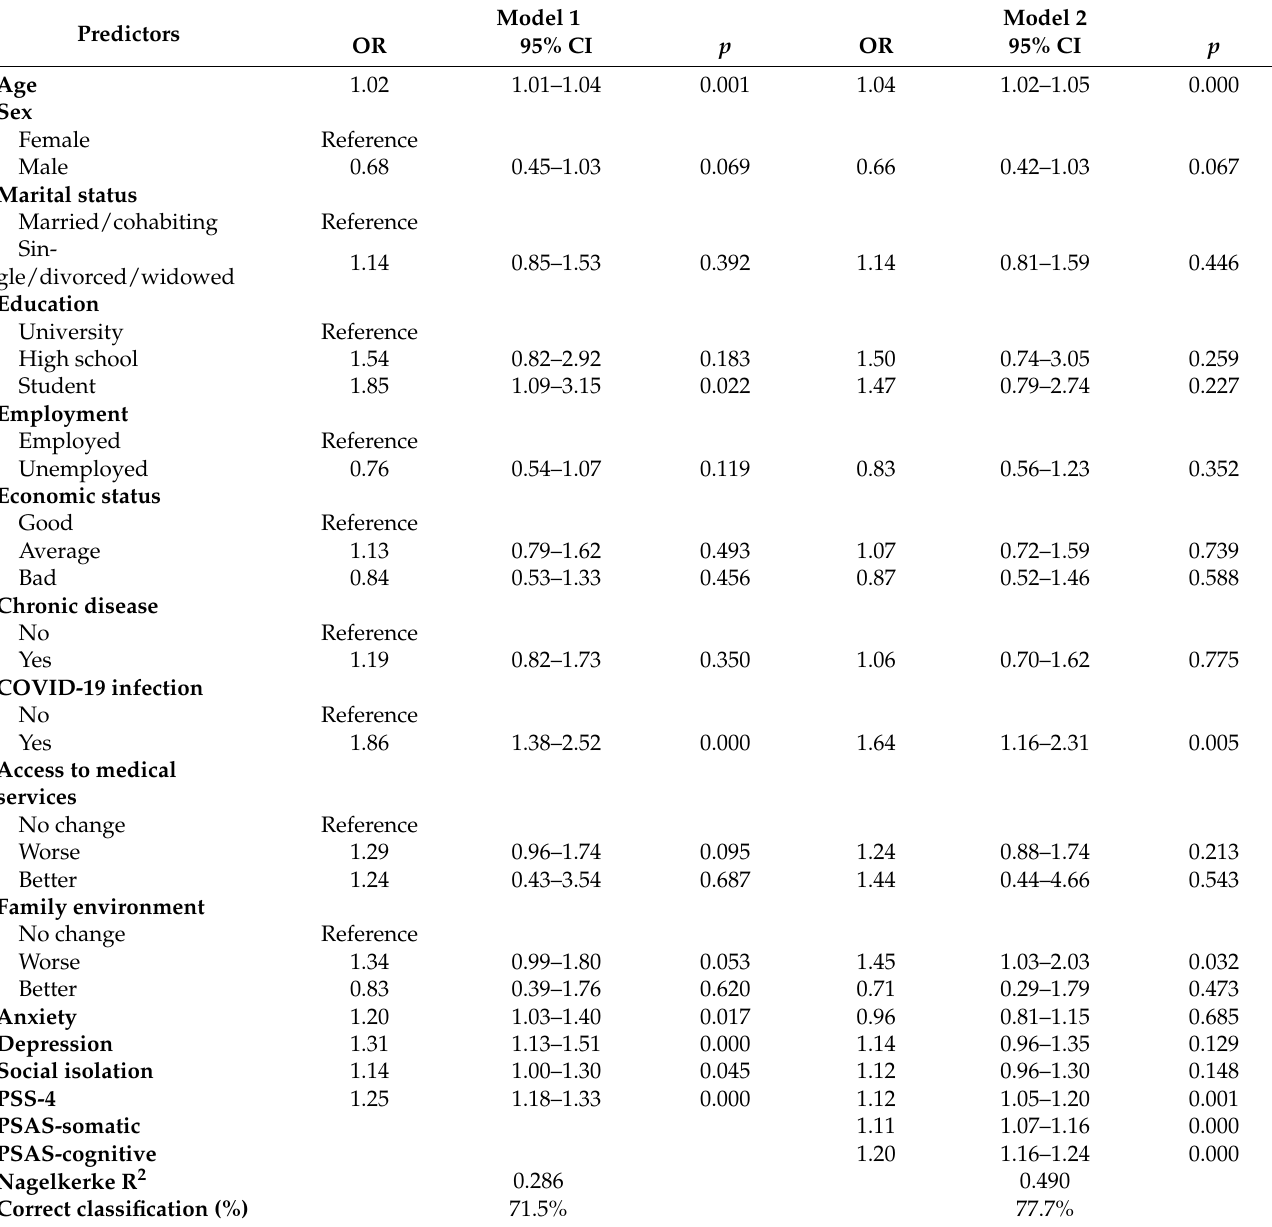
Table 2. Prediction of poor sleep quality (PSQI >5) based on the logistic regression